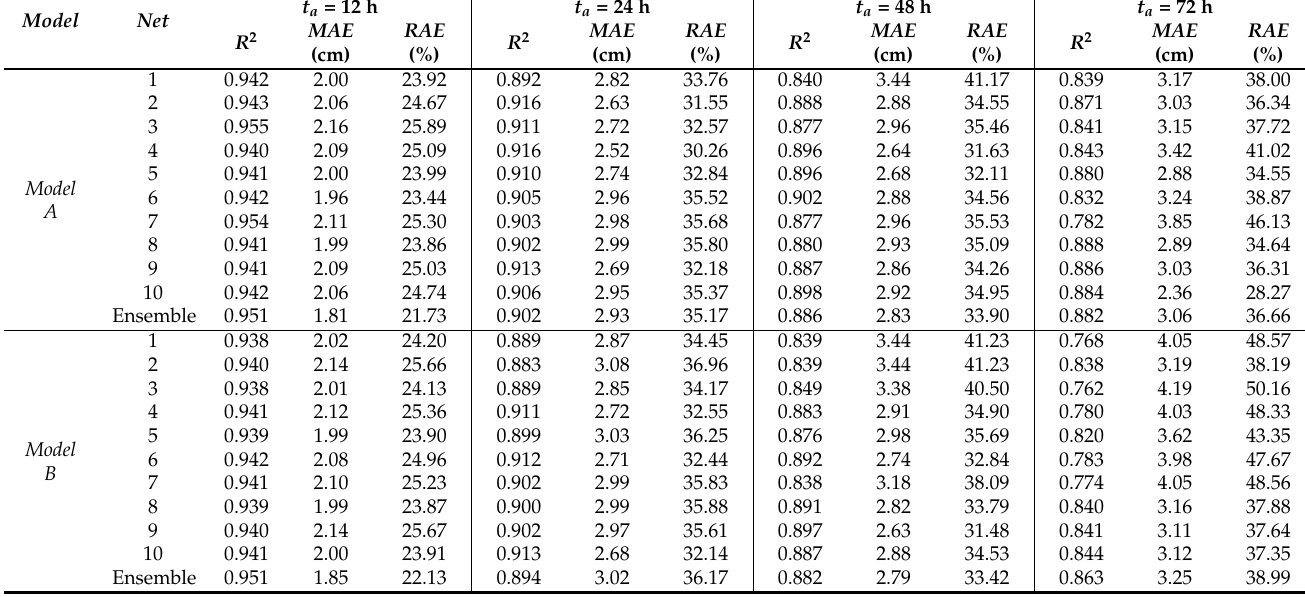
Figure A1. Sketch of the ensemble model. Table A1. Forecasting performance—Ensemble model.